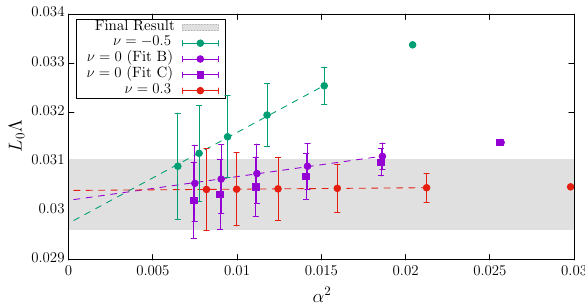
Fig. 4 Determination of the (cid:2) -parameter in units of L 0 at different values of α . We compare the extraction in different schemes ( ν = − 0 . 5 , 0 , 0 . 3), and show a comparison with our final result Eq. (4.27). As the reader can see when the extraction is performed at high enough energies ( α ∼ 0 . 1), all schemes nicely agree. See the text for a full